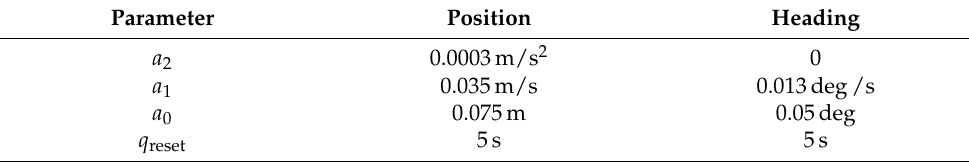
Table 4. Parameters for dynamic lower bound for KIPL integrity